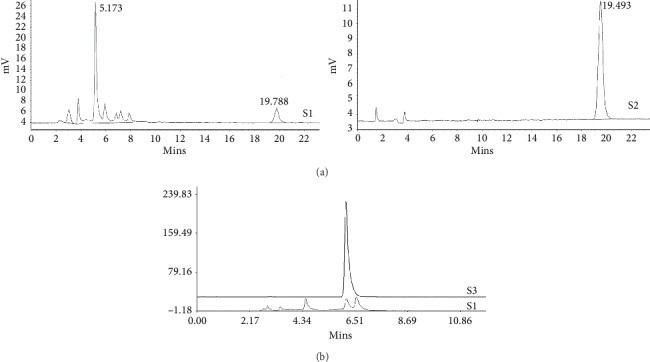
RLT-03 contains astragaloside (AS) and chlorogenic acid (CGA). (a) ELSD analysis of RLT-03 HM. AS was identified in RLT-03. S1 represents AS at the retention time of 19.788 min, which is consistent with the astragaloside standard sample. (b) HPLC analysis of RLT-03 medicine. S1 represents CGA at the retention time of 6.197/6.613 min which is consistent with the chlorogenic acid standard sample (S1, the RLT-03 sample; S2, the AS standard sample; S3, the CGA standard sample).